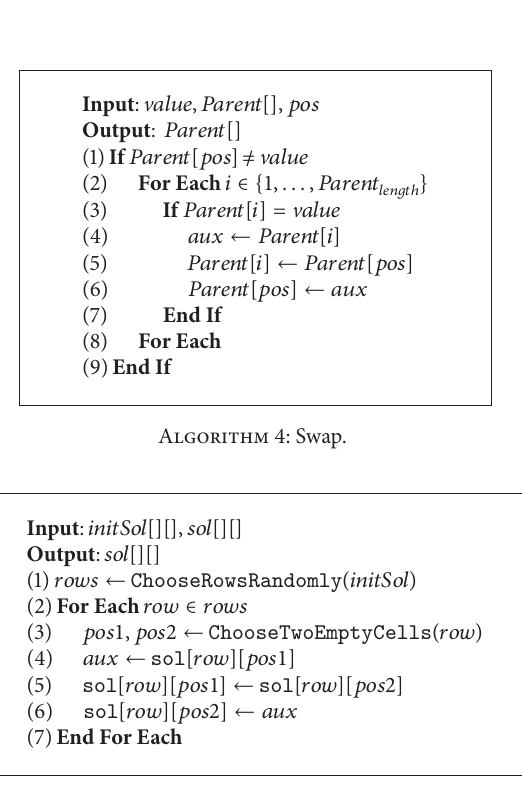
Algorithm 5: Feasible geometric